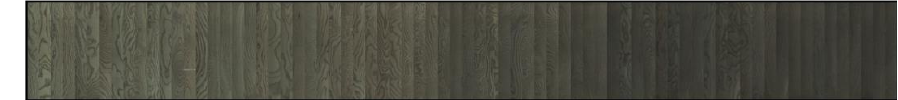
Figure 5. Sequence from shallow to deep solid wood floors.